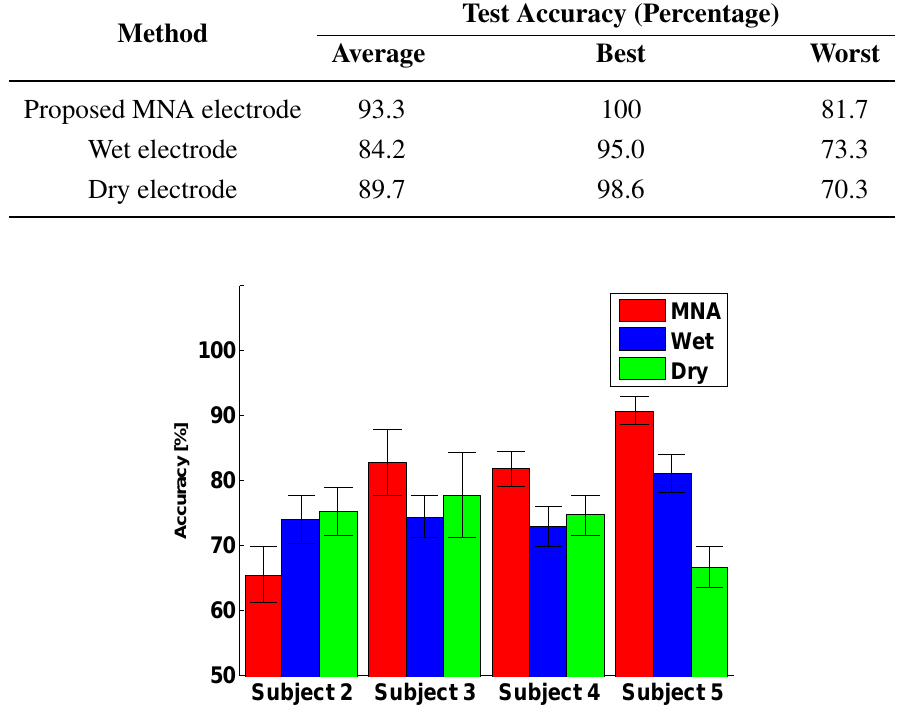
Figure 16. Classification accuracies for Subject 2 to Subject 5. In the case of Subject 2,